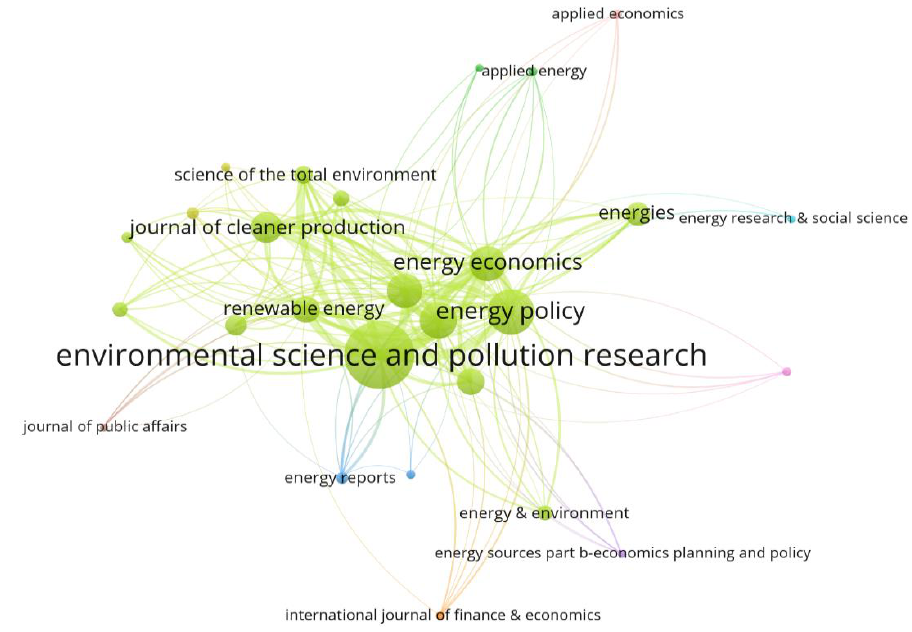
Figure 4. The distribution map of core journals.